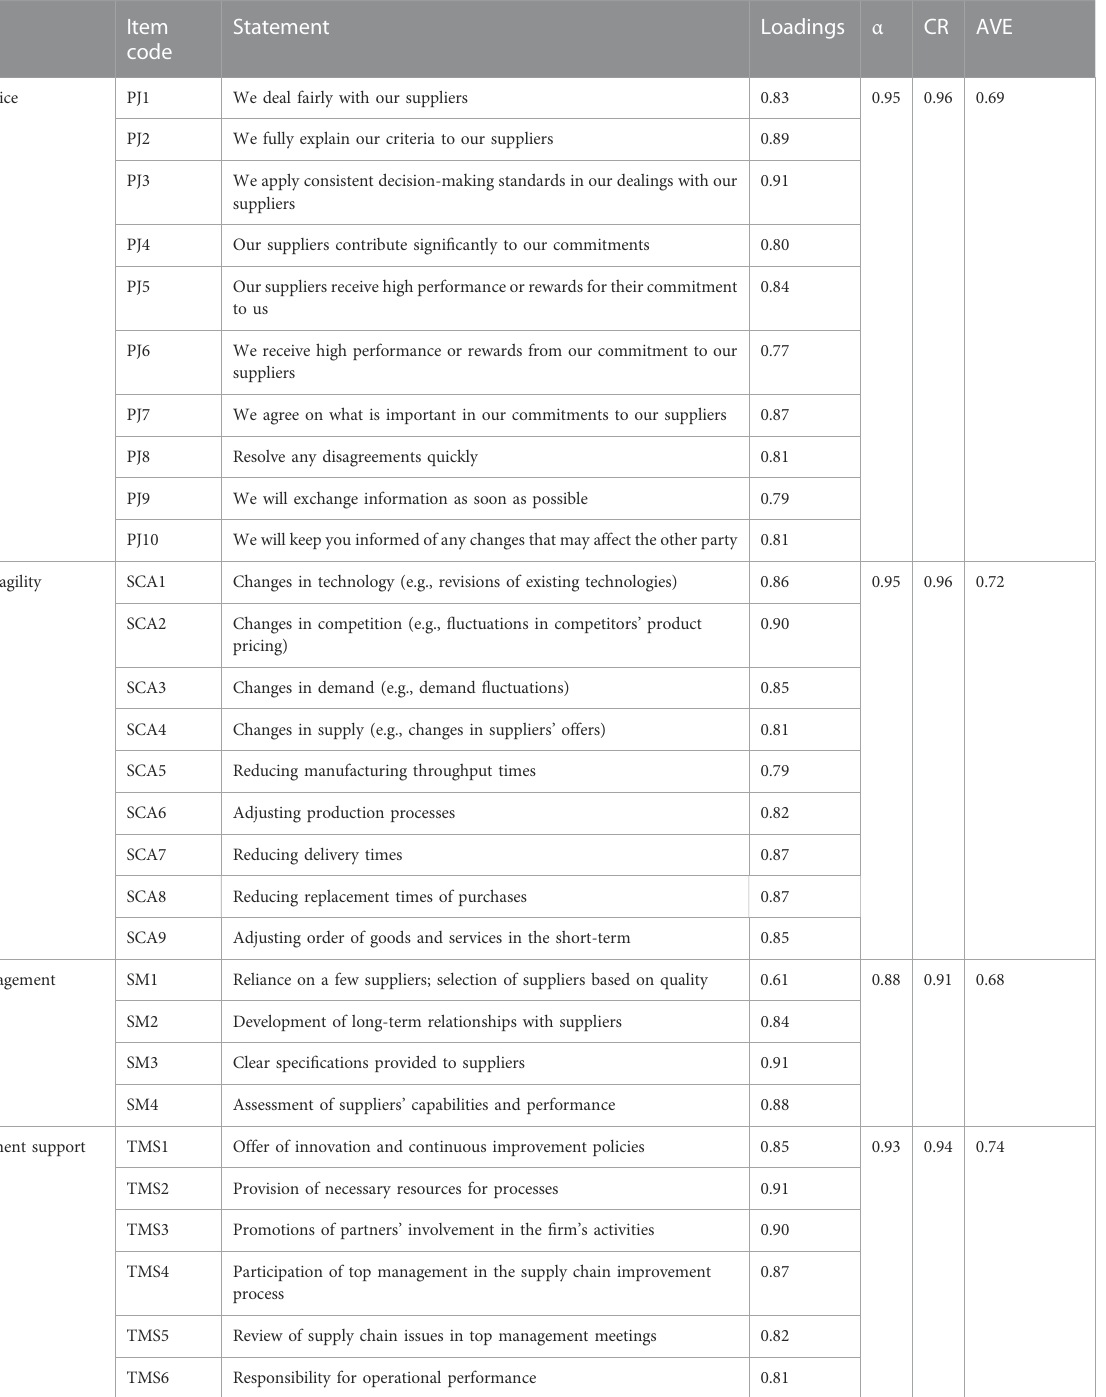
TABLE 2 Convergent validity of